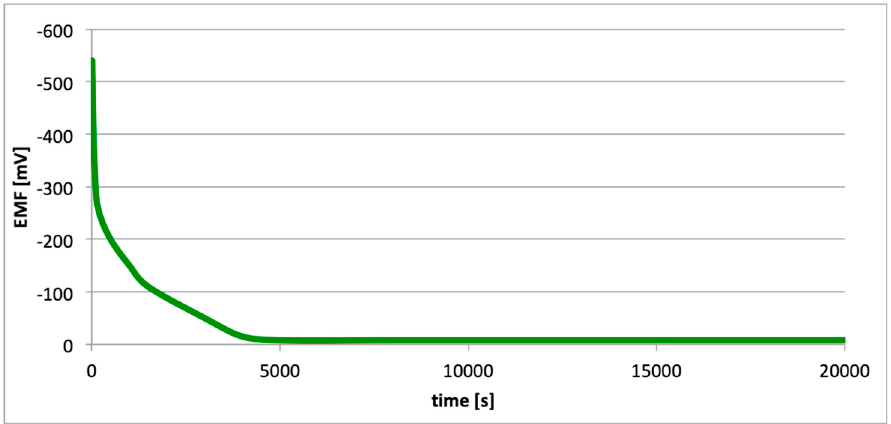
Figure 18. Decrease of cell EMF in time, accompanying absence of passive layer (EN AW-6060).